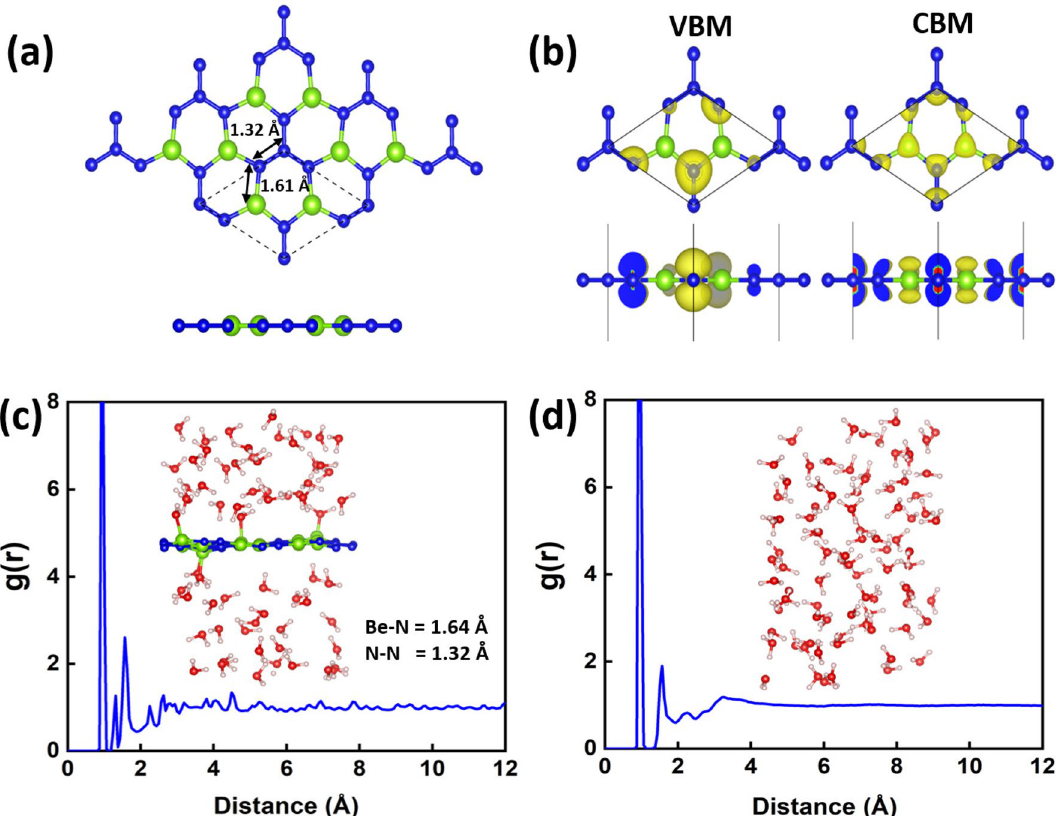
Figure 1. This figure shows some results for a monolayer of BeN 2 : ( a ) Schematic geometrical structure in top and side views (the dashed lines indicate the unit cell); ( b ) Top and side views of isosurface plots of the charge densities at the VBM and CBM, respectively (the isosurface value is 0.008 e Å − correlation functions g(r) of ( c ) BeN 2 monolayer in liquid water and ( d ) liquid water after annealing at 300 K for 5 ps. The inset in ( c ) shows the structural evolution of the BeN 2 in liquid water and average bond lengths of Be-N/N-N. The inset in ( d ) shows the structural evolution of water molecules after annealing at 300 K for 5 ps, respectively. Be, N, O, and H atoms are marked in green, blue, red, and beige,